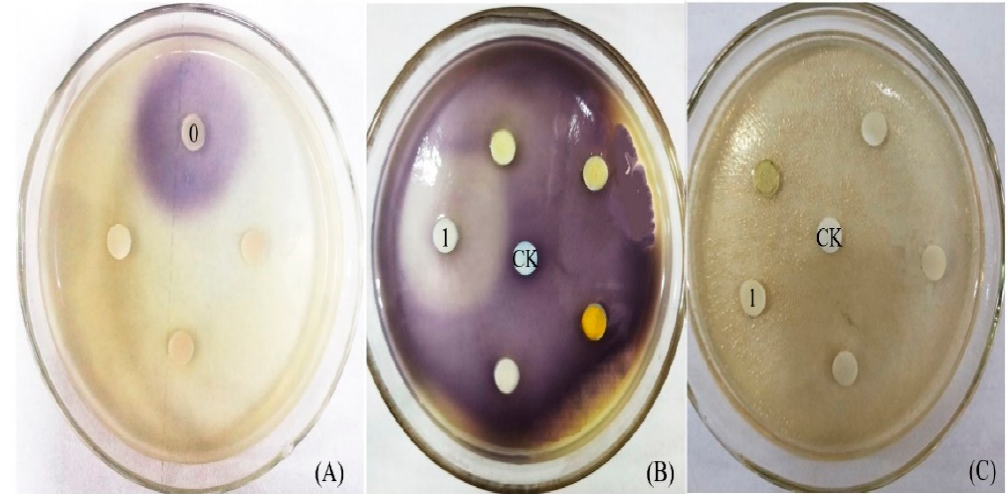
Figure 1. The QSI activity of C. grandiflora flower extract and CFEE identified by report plates. ( A ) and ( C ) LB agar plate incubated by C. violaceum 026; ( B ) LB agar plate supplemented by C 6 -HSL and incubated by C. violaceum 026; “CK”, negative control loading with methanol; “0”, C 6 -HSL; “1”, CFEE.